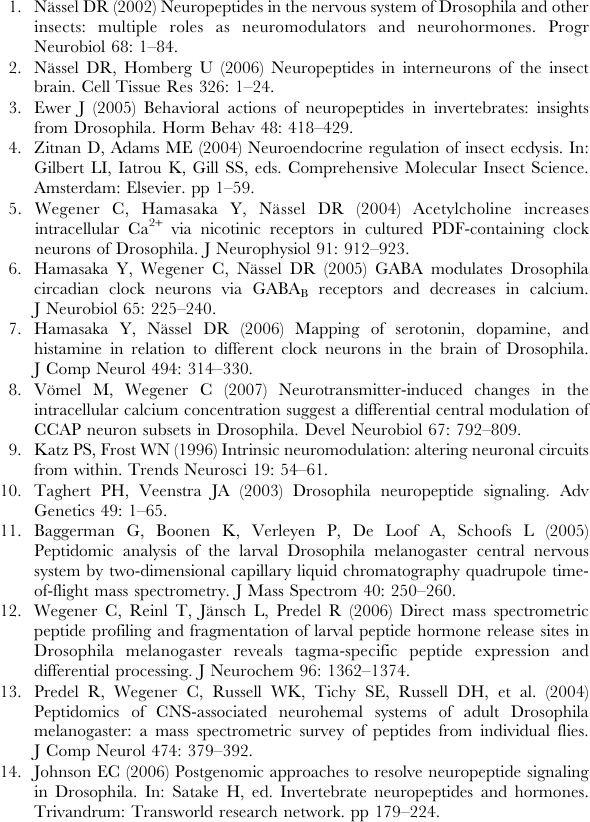
bars =20 m m. Immunostaining or marker protein expression is shown in green, Fas2 in magenta. Figure S7 Details of the morphology of TRP neurons. Voltex projections of TRP-IR varicosities in different neuromeres. A) Dorsal view of a3–a4. B) Posterior view of transverse section at the height of t3. C) Dorsal view of a pair of TRP-IR neurons (asterisks) in t2. D) Dorsal view of a3. Scale bars = A) 20 m m, B–D) 30 m m. Immunostaining is shown in green, Fas2 in magenta. Figure S8 Distribution of c929-GAL4 driven expression of SYB.EGFP and CD8.GFP. Dorsal view of maximum projections of the VNC in gray scale (GS) or false color coding (FC). In FC, low staining intensity is coded by blue, high staining intensity by red. Each row represents a separate preparation. Strongest accumulation of SYB.EGFP is visible in the thoracic PSOs (arrows) and descending lateral and intermediate fascicles, whereas the terminal plexus (arrowhead) only shows relatively little fluorescence. In contrast, CD8.GFP fluorescence is most intense in the terminal plexus and in median and lateral fascicles, and missing in the thoracic PSOs. Scale bars = 100 m m. Found at: doi:10.1371/journal.pone.0000695.s008 (4.71 MB TIF) Video S1 3D reconstruction of the Fas2 landmarks. Movie of a full reconstruction of the Fas2-positive tracts in the ventral nerve cord of a L3